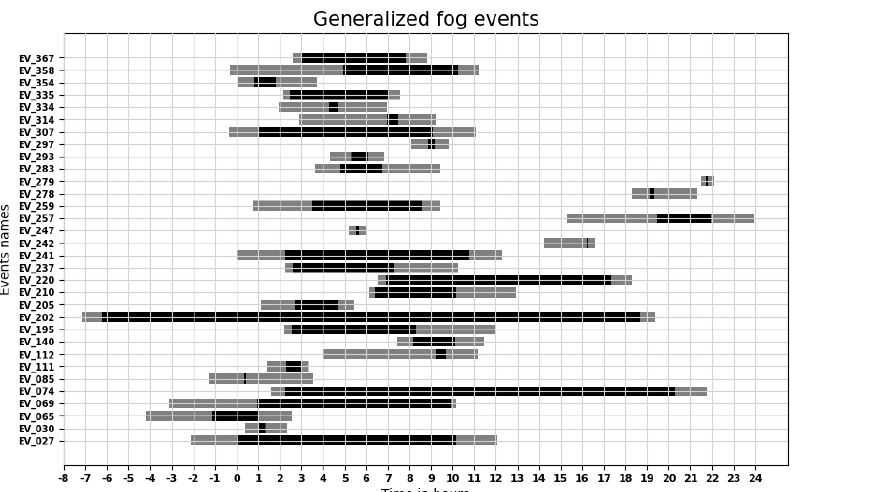
Figure 11. Generalized fog events: mature phase (black) and formation and dissipation phases (gray). Time in UTC; negative hours indicates that the events start on the previous